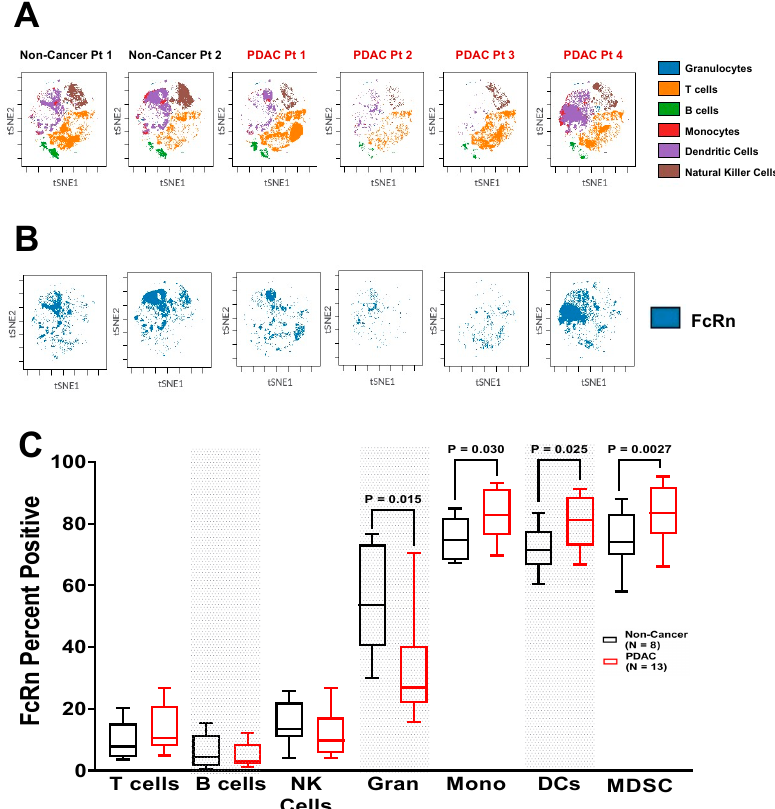
Figure 4. Circulating Myeloid Cells Expressing FcRn are Elevated in PDAC Patients. PBMCs of non- cancer ( n = 8) and PDAC ( n = 13) patients were permeabilized and stained for FcRn. Representative t-SNE plots of the ( A ) most prevalent cell populations; and ( B ) FcRn localization from two individual non-cancer and four individual PDAC patients are shown. ( C ) Quantification of FcRn expression within each immune population. Granulocytes are denoted as Gran, and monocytes are denoted as Mono. Biological replicates represent staining and analyses of each individual sample. Individual biological replicates were combined into box and whisker plots representing the median and interquartile range (25–75%) with whiskers representing the outlying 25%. All statistical comparisons are unpaired t -tests with a Welch’s correction.